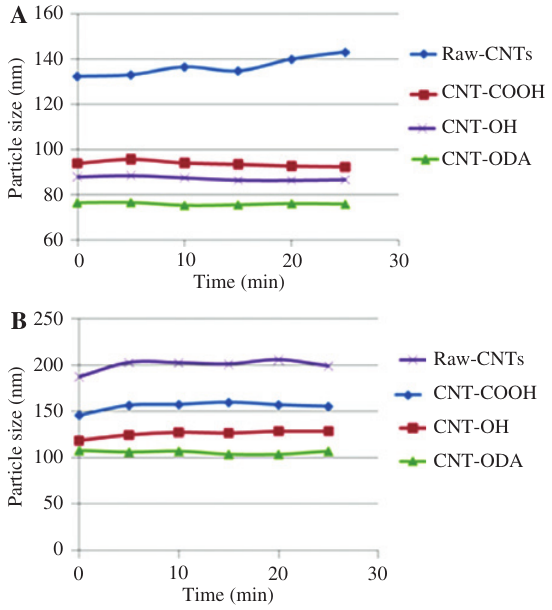
Figure 2: Particle size of various f-CNTs in (A) epoxy resin solution and (B) TETA solution from 0 to 25 min (5 wt% in xylene-butanol